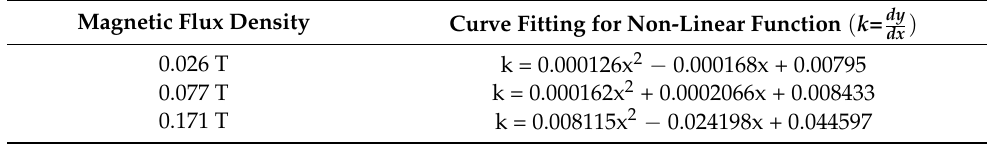
Table 4. Stiffness approximated by polynomial function in the cantilever structure with MR